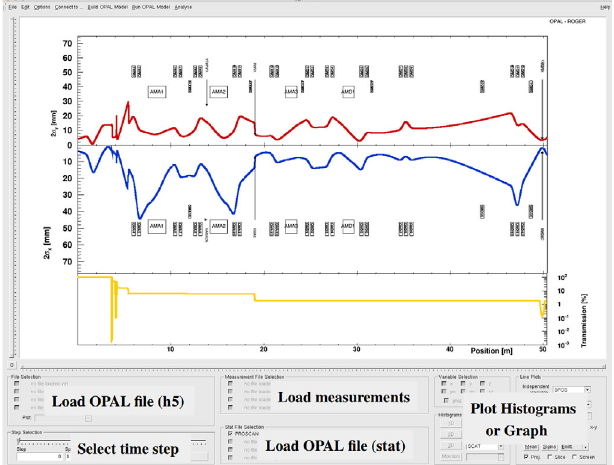
FIG. 3. ROGER GUI and example of a data analysis. In the white canvas the beamline lattice, envelope (blue and red line for the horizontal-bending and vertical plane, respectively) and transmission (yellow line) are displayed. In the bottom part of the GUI, some basic ROGER functionalities (e.g., load files, plot options) are